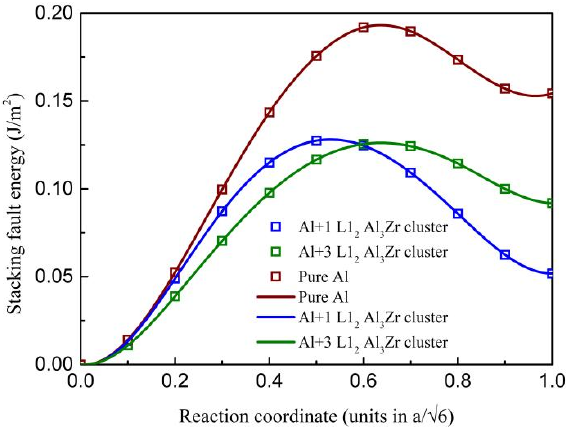
Figure 6. The generalized stacking fault energy (GSFE) curves of the Al supercell with the chemical short ‐ range ordering clusters L1 2 ‐ Al 3 Zr at the faulted region. Table 5. The work of dislocation emission G disl , the work of separation W sep , the unstable stacking fault energy γ usf and the ratio ( W sep / G disl ).